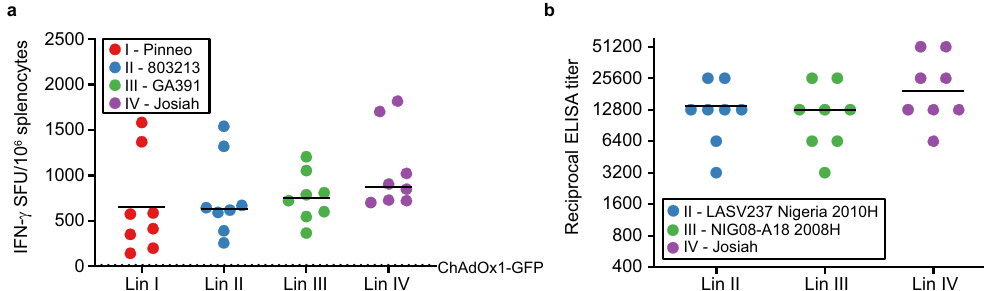
Fig. 2 Vaccine-speci fi c IFN- γ + T cells and IgG antibodies exhibit cross-reactivity to GP from heterologous LASV strains. a CD-1 mice were vaccinated with ChAdOx1-Lassa-GPC ( n = 8) or ChAdOx1-GFP ( n = 2) and euthanized after 14 days for the collection of splenocytes. IFN- γ - secreting T cells were quanti fi ed by ELISpot assay after stimulation with four different peptide pools corresponding to the full-length GPC sequence from a representative strain from LASV lineages I – IV. Responses are reported as spot forming units (SFU) per 1.0 × 10 6 splenocytes. The dotted line indicates the mean response in ChAdOx1-GFP vaccinates. b CD-1 mice were vaccinated with ChAdOx1-Lassa-GPC ( n = 8) or ChAdOx1-GFP ( n = 2) and euthanized after 28 days for sera collection. IgG antibody titers against GP from representative strains from LASV lineages II – IV were measured in twofold serial-diluted sera by ELISA. Josiah strain GP (lineage IV) is homologous to the vaccine antigen. The magnitudes of IFN- γ + T-cell responses and titers of IgG antibodies displaying reactivity to each heterologous strain were determined to be statistically comparable to Josiah strain-speci fi c responses by one-way ANOVA with Dunnett ’ s multiple comparisons test.